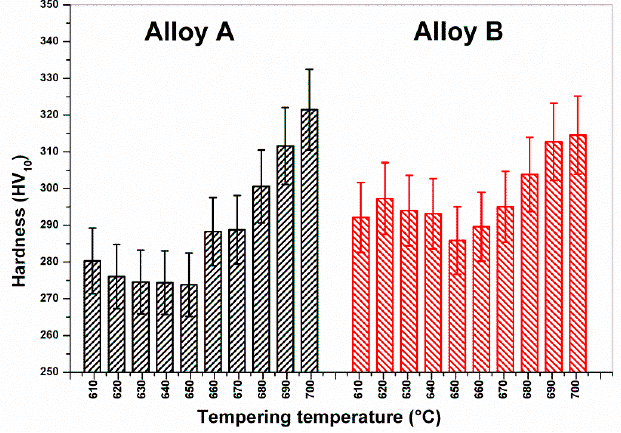
Figure 7. Hardness values for Heat A and Heat B as a function of the single tempering treatment.